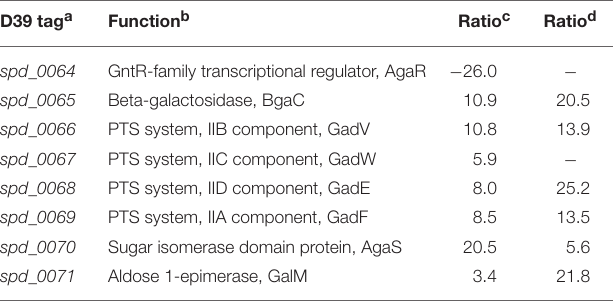
TABLE 4 | Summary of transcriptome comparison of S. pneumoniae D39 wild-type with D39 1 agaR grown in GM17 (0.5% Glucose + M17) and